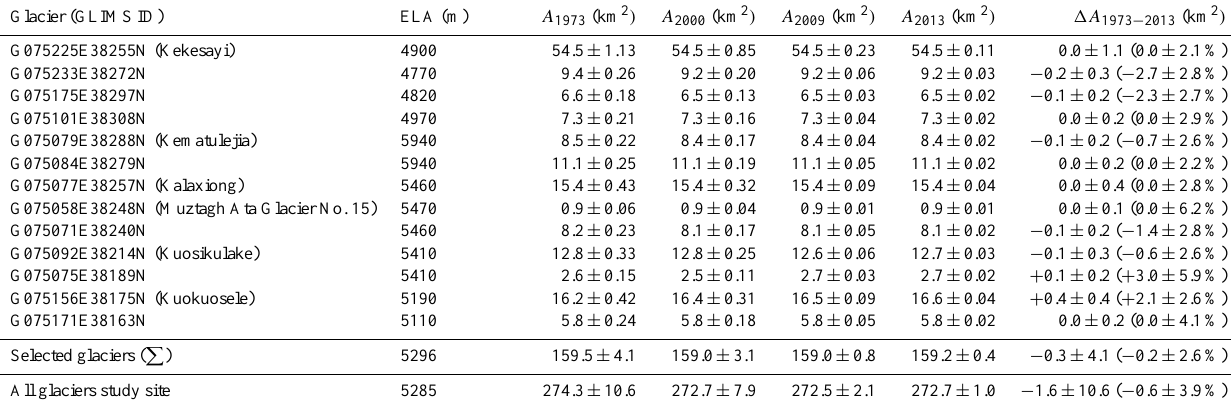
Table 4. Equilibrium line altitude (ELA), glacier area ( A ), and changes ( (cid:49)A ) from 1973–2013 at Muztagh Ata for selected glaciers that have mass-balance estimates and for all glaciers of the study site. Glacier (GLIMS